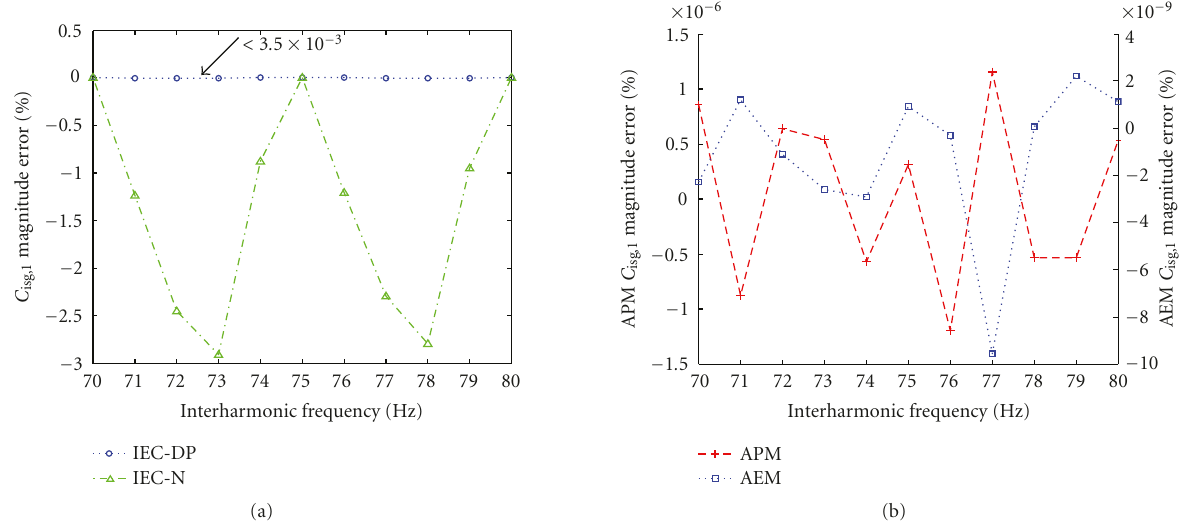
Figure 4: Case study 1: interharmonic subgroup C isg,1 magnitude error (in %) versus interharmonic frequency: (a) IEC-N (- · - Δ ) and IEC- DP (dotted line ◦ ), (b) APM (dotted line +) and AEM (dotted line (cid:3)